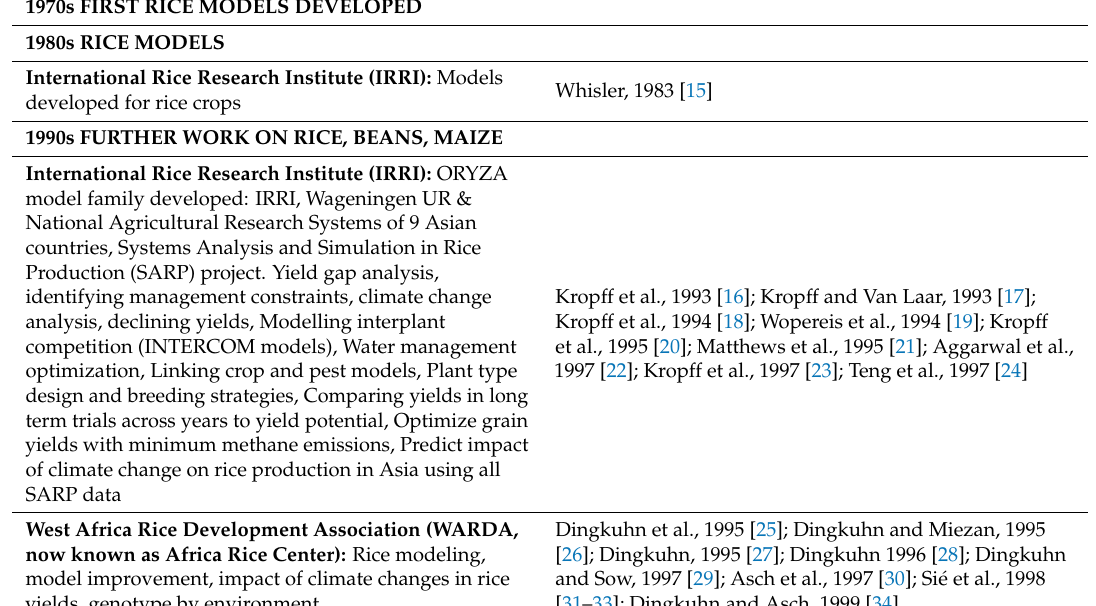
Table 1. Modelling developments by CGIAR centres, 1970s to